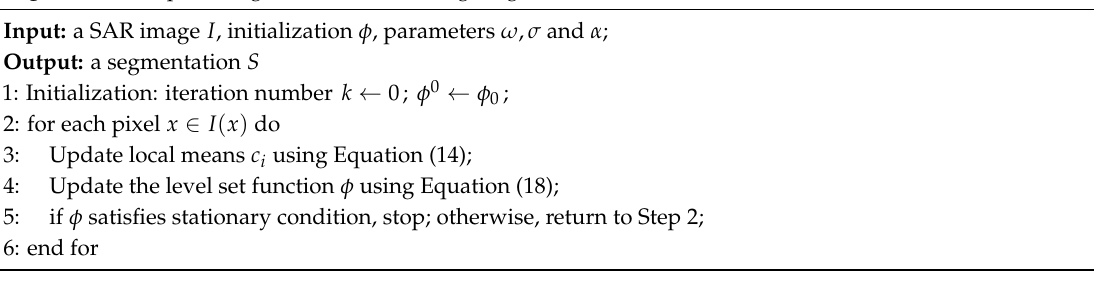
Algorithm 1 Proposed algorithm for SAR image segmentation